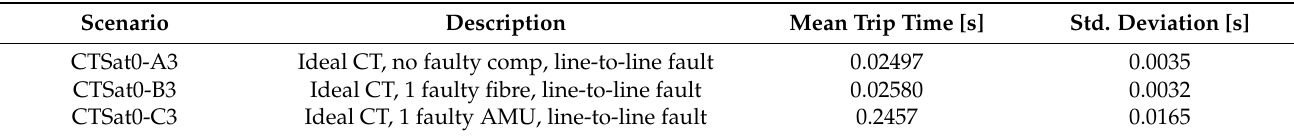
Table 6. Trip times for line-to-line fault.